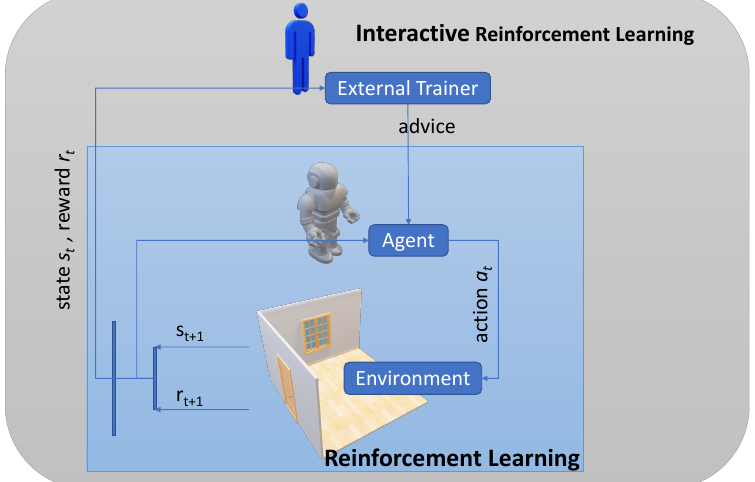
Figure 1. At state s t , the agent performs action a t , obtains reward r t + 1 , and reaches the next state s t + 1 in conventional RL. In the IRL model, the involvement of an external trainer gives the agent more options to chose which action to perform next in the following